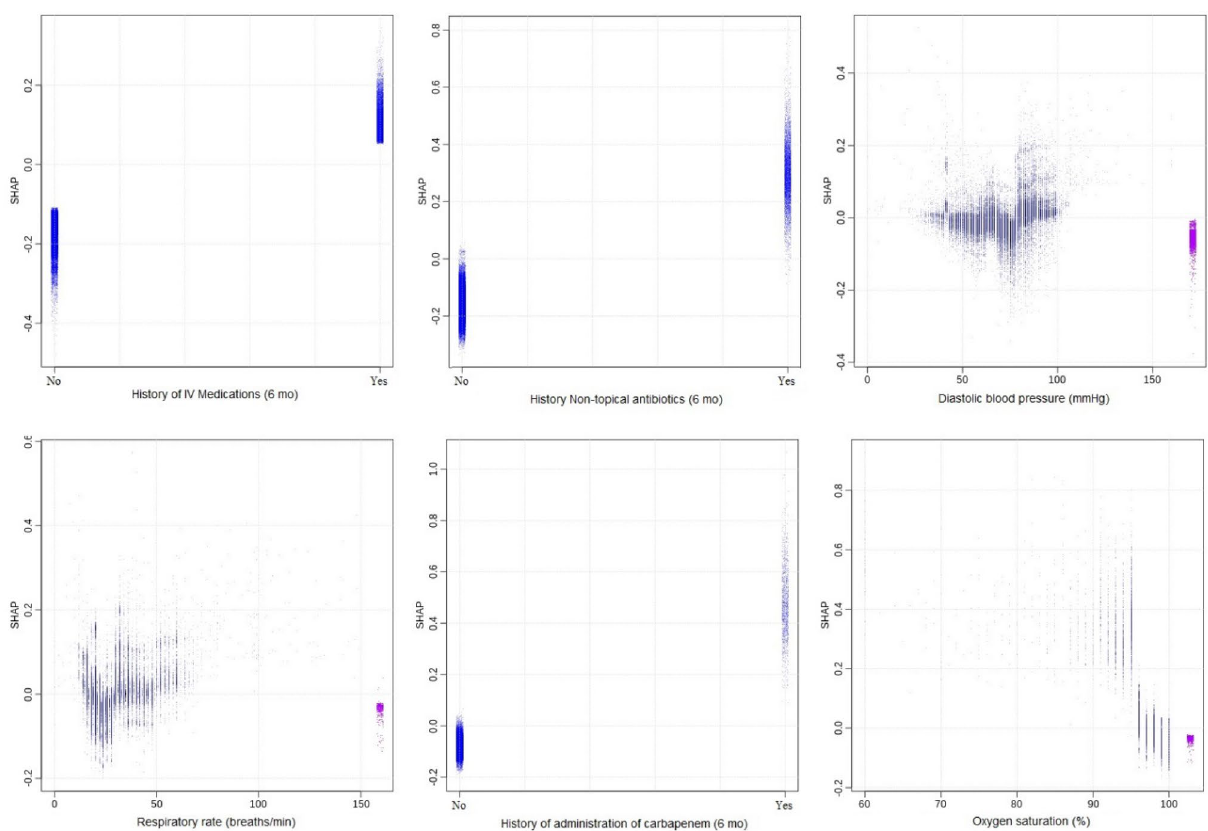
Figure 3. Shapley additive explanations for severe sepsis: second 6 most important